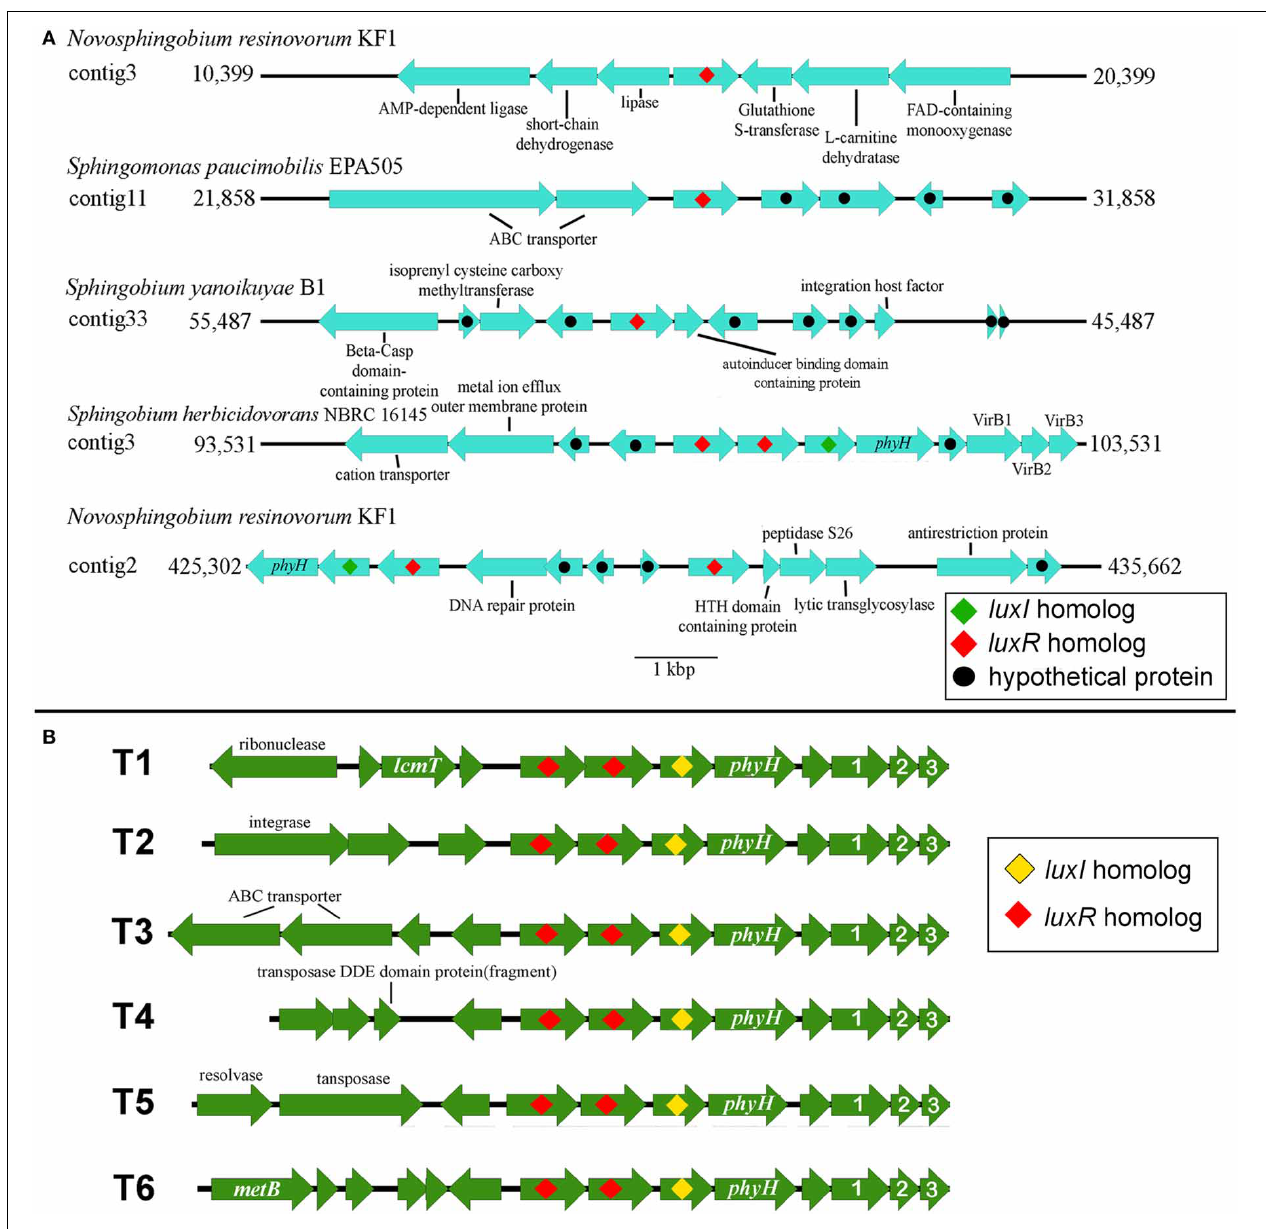
FIGURE 5 | Gene organization of luxR Solos and luxR-luxR-luxI in the four whole genome sequenced sphingomonads. (A) EasyFig generated linear comparison of luxR solos in the genomic region of selected sphingomonads. Approximately 5000bp of genomic region flanking the luxR solos is shown. (B) Gene orientation of the identified convergent double luxR, luxI group and its gene neighborhood variation. T1 to T6 denotes different gene neighborhoods